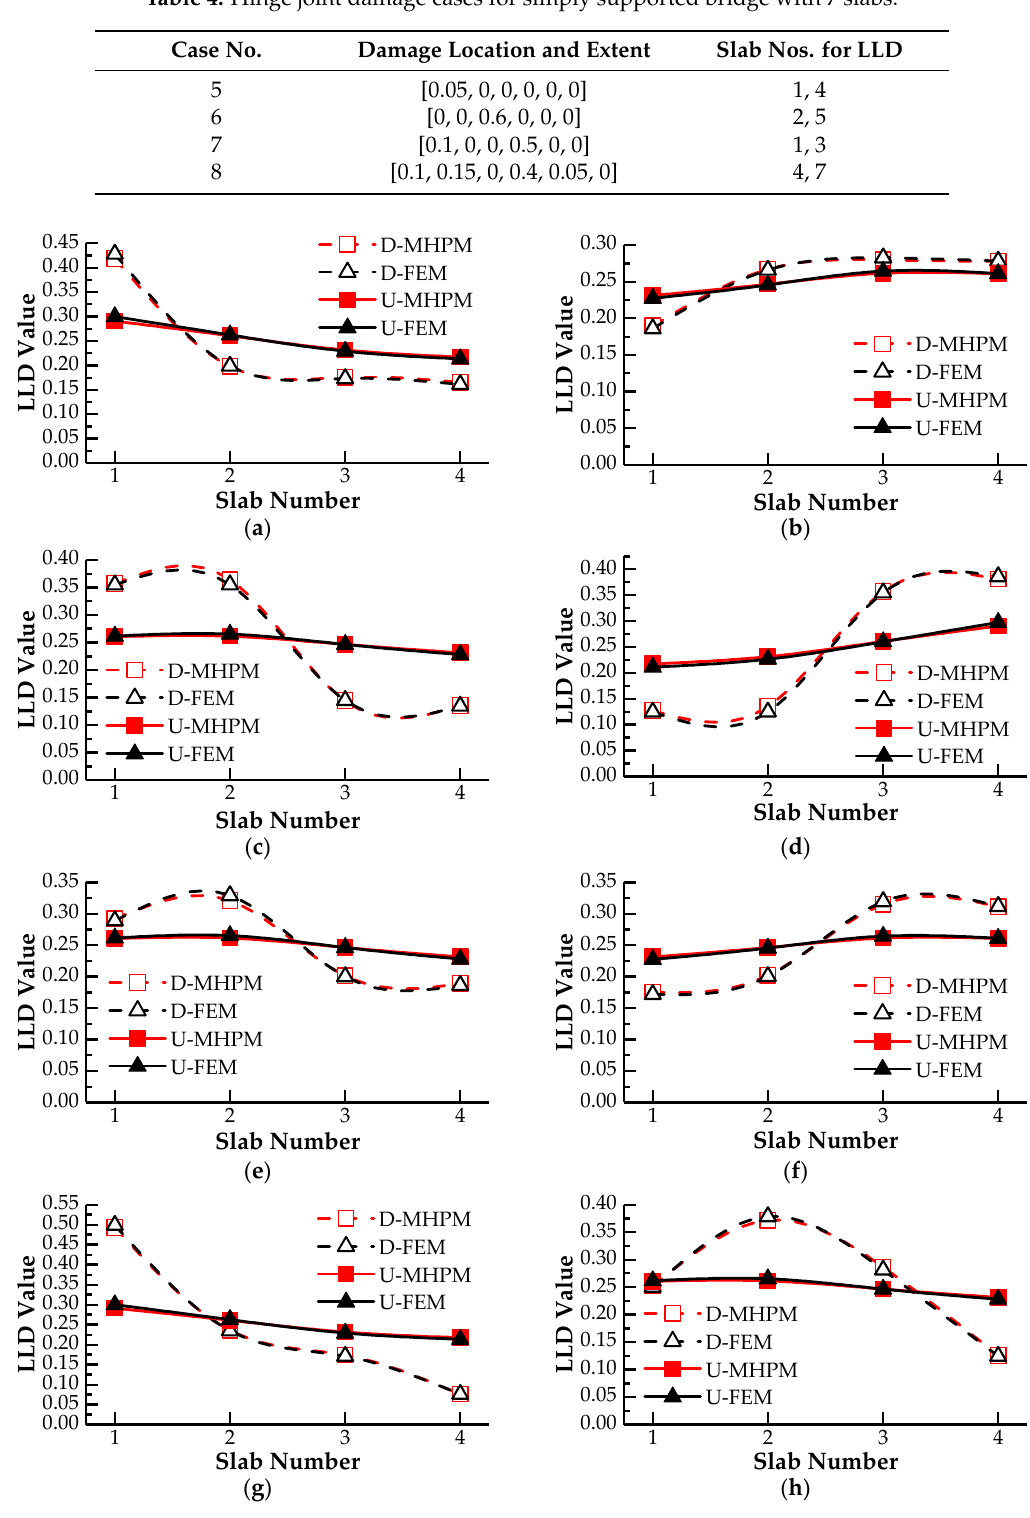
Figure 7. LLD influence lines under damage and intact cases of 4-slab bridge: ( a ) case 1: slab 1; ( b ) case 1: slab 3; ( c ) case 2: slab 2; ( d ) case 2: slab 4; ( e ) case 3: slab 2; ( f ) case 3: slab 3; ( g ) case 4: slab 1; ( h ) case 4: slab 2.